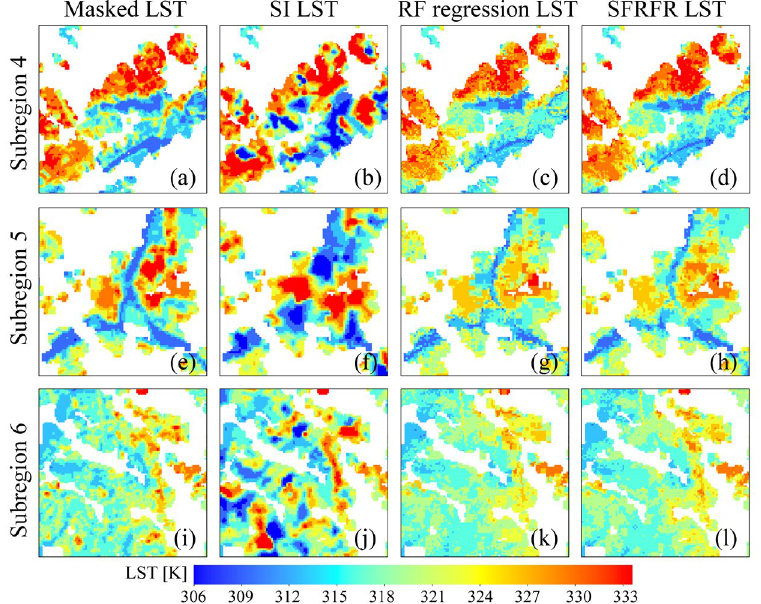
Figure 6. Visual performances of the reconstructed LST generated by the three models and the extracted LST in regions 1, 2, and 3: ( a ) extracted LST in region 1, ( b ) SI LST in region 1, ( c ) RF regression LST in region 1, ( d ) SFRFR LST in region 1, ( e ) extracted LST in region 2, ( f ) SI LST in region 2, ( g ) RF regression LST in region 2, ( h ) SFRFR LST in region 2, ( i ) extracted LST in region 3, ( j ) SI- LST in region 3, ( k ) RF regression LST in region 3, and ( l ) SFRFR LST in region 3.